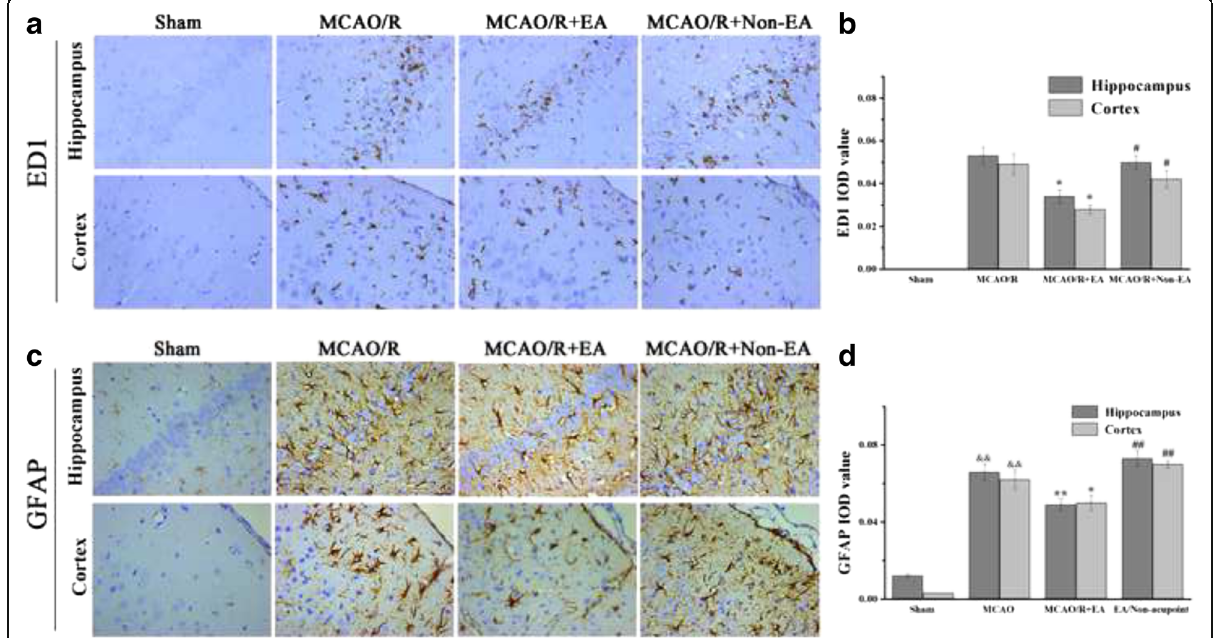
Fig. 4 Effects of EA on astroglial and microglial/macrophage hyperplasia after MCAO/R injury. a , c Immunohistochemistry of ED1-positive and GFAP-positive cells in peri-infract hippocampal CA1 and sensorimotor cortex of each groups at Day 7 after EA treatment (brown cells, Scale bar = 20 μ m). b , d Quantification of microglial/macrophage and astroglial positive cells showed lower density in the MCAO/R + EA group compared to the MCAO/R group and the MCAO/R+ Non-EA group. ED1-positive and GFAP-positive IOD in regions (0.3 × 0.2 mm 2 ) were counted. Data are shown as mean ± S.E.M from 6 individual rats in each group. && P < 0.01, the MCAO/R group versus the Sham group; ** P < 0.01, * P < 0.05, the MCAO/R + EA group versus the MCAO/R group; ## P < 0.01, # P < 0.05, the MCAO/R + EA group versus the MCAO/R+ Non-EA group